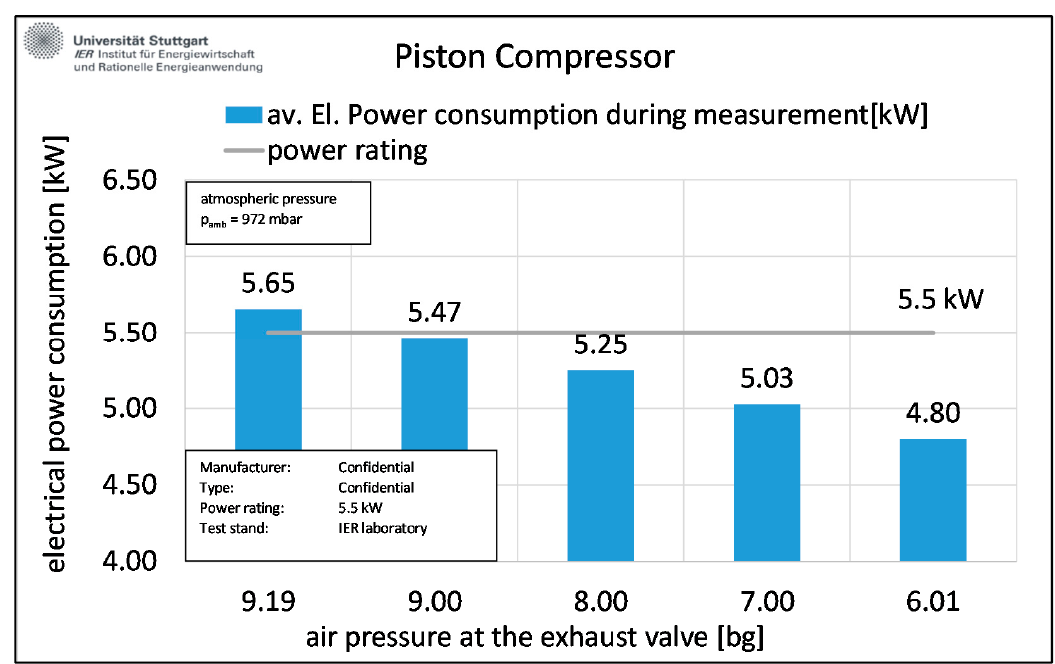
Figure 4. Electric power demand of a compressor with 5.5 kW nominal power and maximum pressure capacity of 10 barg with respect to the pressure at the exhaust valve (source: own representation).